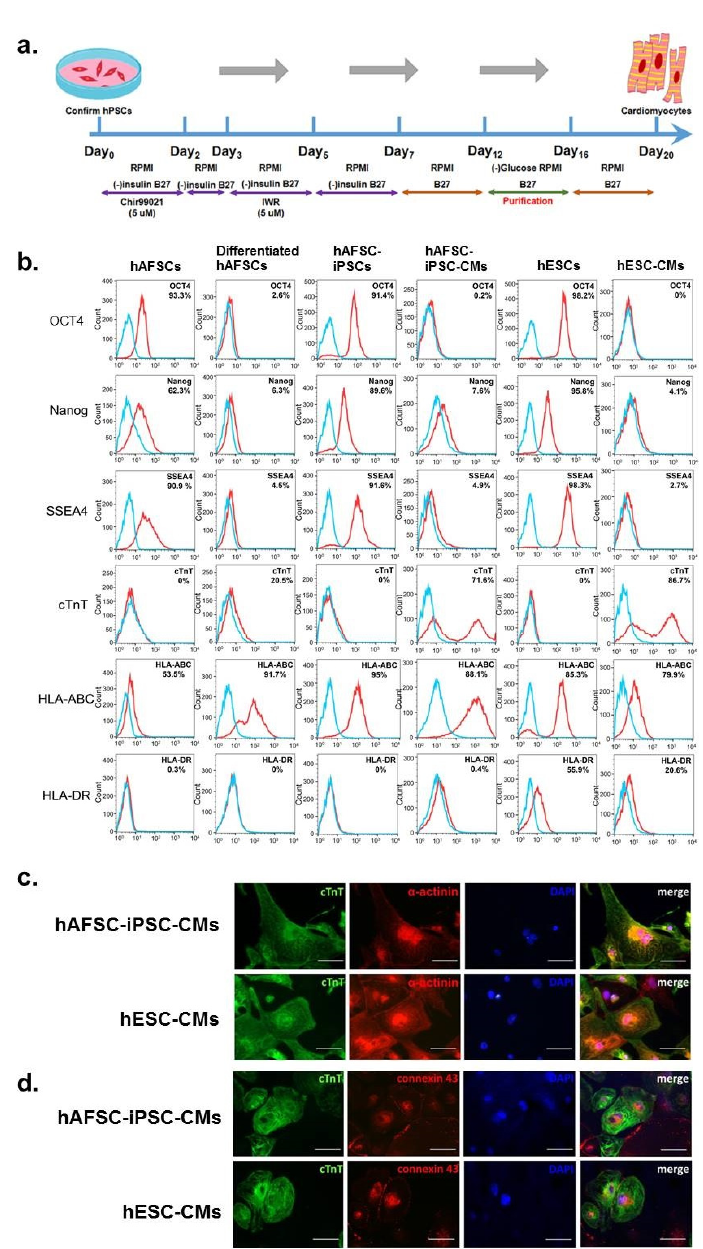
Figure 1. Characterization of human amniotic fluid-derived stem cells (hAFSCs) and hAFSC-induced pluripotent stem cells (hAFSC-iPSCs). ( a ) Schematic presentation of the monolayer direct cardiac differentiation protocol. ( b ) Flow cytometry analyses of cell markers were performed to characterize undifferentiated and cardiac-differentiated stem cells. Pluripotency markers (i.e., OCT4, Nanog and SSEA4), cardiac-specific marker (cardiac troponin T, cTnT), and immune-related surface markers (human leukocyte antigens [HLA]-ABC and HLA-DR) were stained to characterize the hAFSCs and the hAFSC-iPSCs 21 days after cardiac differentiation. Human embryonic stem cells (hESCs) and hESC-derived cardiomyocytes (hESC-CMs) were used as controls. Isotype controls are in blue and the surface markers are in red. The expression of each surface marker or isotype control was analyzed on 100,000 cells. Like hESC-CMs, the hAFSC-iPSC-CMs, but not differentiated AFSCs, had a typical bimodal distribution of cardiac differentiation. Furthermore, both hAFSC-iPSCs and hAFSC-iPSC-CMs expressed HLA-ABC but not represent HLA-DR. ( c ) Immunofluorescence staining revealed that hESC-CMs and hAFSC-iPSC-CMs expressed cTnT at day 21 of cardiac differentiation. ( d ) Connexin43 gap junction channels were identified in both hESC-CMs and hAFSC-iPSC-CMs. Scale bar of c & d, 50 µ